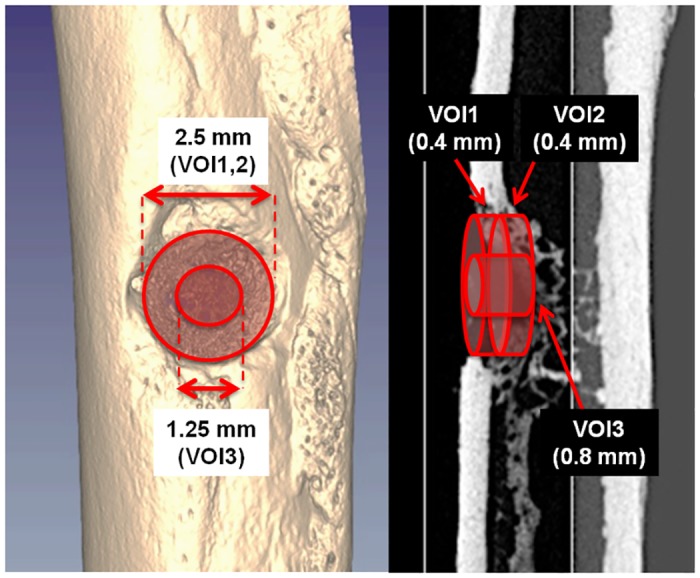
Representative ex vivo micro-CT images showing the VOIs used for quantitative analysis.